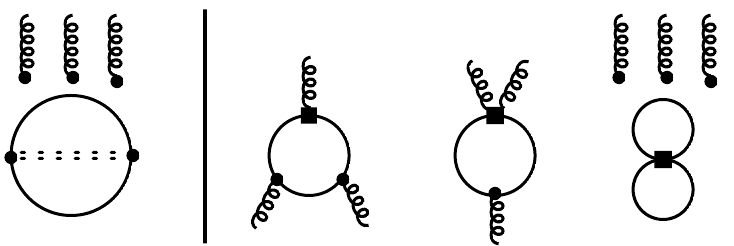
Figure 2 . Left panel: two-loop diagrams contributing to the Weinberg operator in the full theory including dynamical leptoquarks. Right panel: one- and two-loop diagrams contributing to the Weinberg operator in the EFT where leptoquarks have been integrated out. The disconnected gluons in the (cid:12)rst and fourth diagram can attach to any internal line carrying color charge. Other notation as in (cid:12)gure